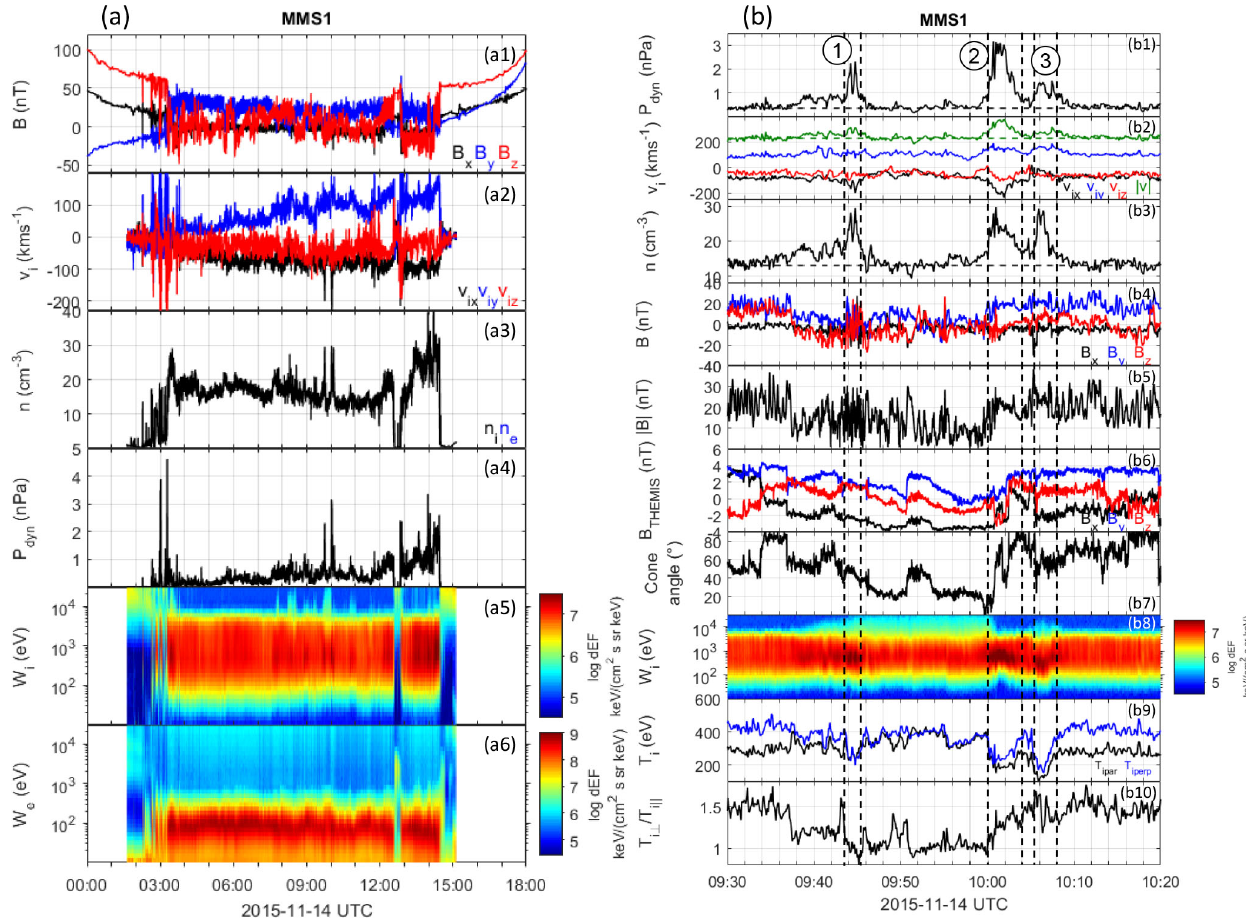
Figure 1. (a) Overview of MMS1 measurements in the magnetosheath on 14 November 2015. From top to bottom is shown magnetic field B , ion velocity v i , ion and electron density ( n i and n e ), dynamic pressure P dyn , and omnidirectional ion and electron differential energy flux. (b) From top to bottom: P dyn (with three localized increases indicated), v i and | v i | , n i , B , | B | , THEMIS B magnetic field (shifted by 21min), THEMIS B magnetic field cone angle, omnidirectional ion differential energy flux, ion and parallel and perpendicular ion temperatures ( T i ⊥ , T i (cid:107) ), and ion temperature anisotropy ( T i ⊥ /T i (cid:107)